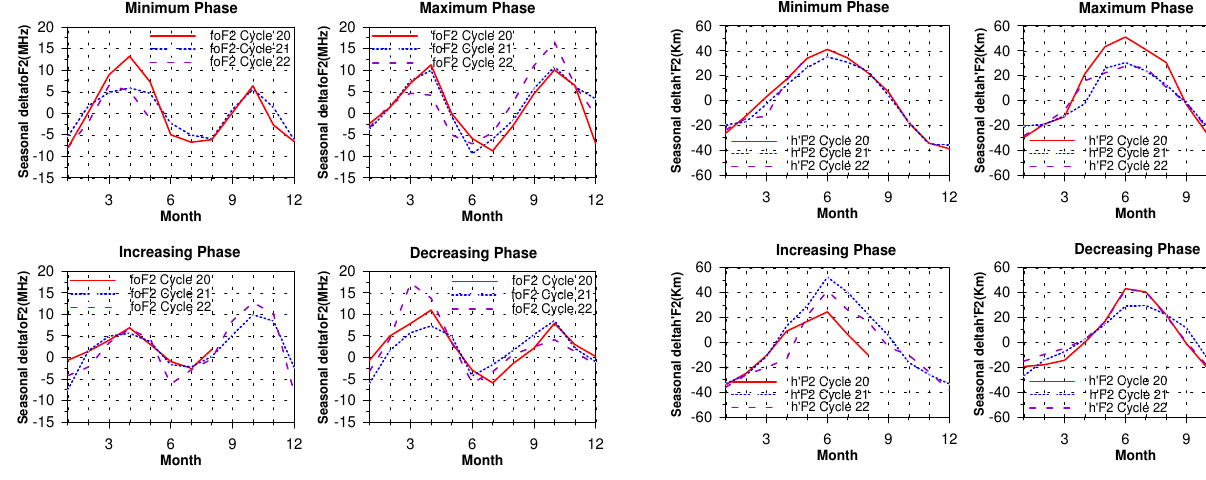
Fig. 4. Seasonal variation of the critical frequency 1 fo F2, after elimination of the solar influences (Rz), during the various phases of the sunspot cycles: minimum phase (top left panel), increasing phase (bottom left panel), maximum phase (top right panel) and decreasing phase (bottom right panel). The red curves correspond to sunspot cycle 20, the dashed blue curves to sunspot cycle 21 and the violet curves to sunspot cycle 22.